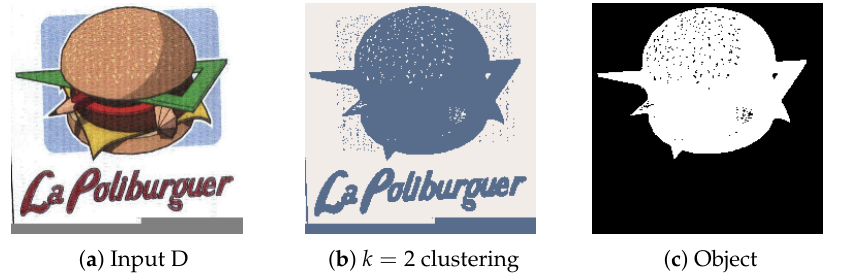
Figure 13. ( a ) Experiment D input; ( b ) Experiment D K-Means clustering ( k = 2); ( c ) Experiment D extracted